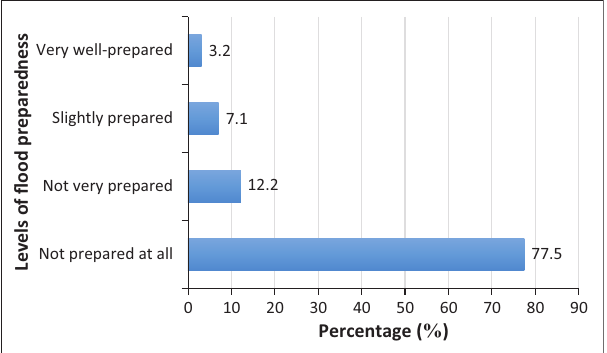
FIGURE 6: Percentage of respondents’ rank of level of preparedness.